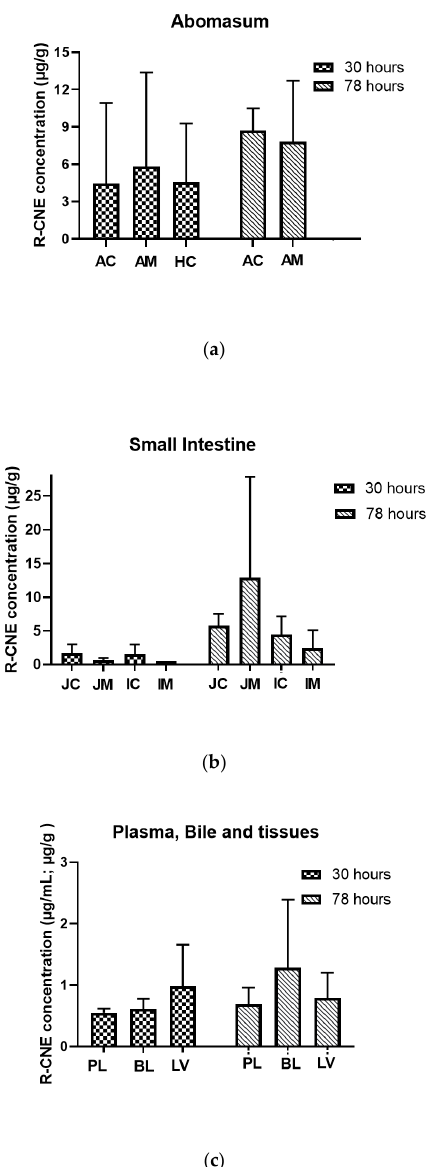
Figure 5. Mean (±SD) carvone (R-CNE) concentrations obtained in plasma, target tissues, and H. contortus after its oral administration as an emulsion (four doses every 24 h of 100 mg/kg) in a fixed combination with ivermectin (one dose, 0.2 mg/kg)) to lambs ( n = 6) artificially infected with resistant H. contortus . ( a ) AC: abomasum content, AM: abomasum mucosa, HC: H. contortus ; ( b ) JC: jejunum content, JM: jejunum mucosa, IC: ileum content, IM: ileum mucosa; ( c ) PL: plasma, BL: bile, LV: liver. R-CNE concentrations measured at 78 h were significantly higher compared to those measured at 30 h post treatment for JC, JM, IC, and IM ( p ≤